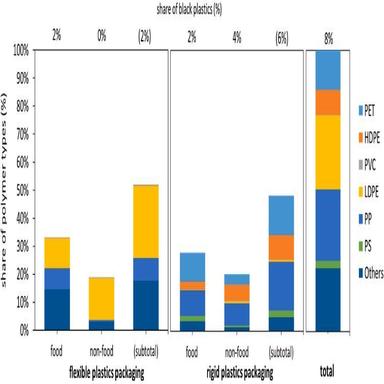
Extended characterization (in %w/w of the sample, on a dry basis) of plastic packaging in mixed MSW from the Swedish case city. From the share of rigid and flexible plastics (2012–2022), characterization was extended in this study (2022) in terms of product application, polymer type, and share of black plastics.